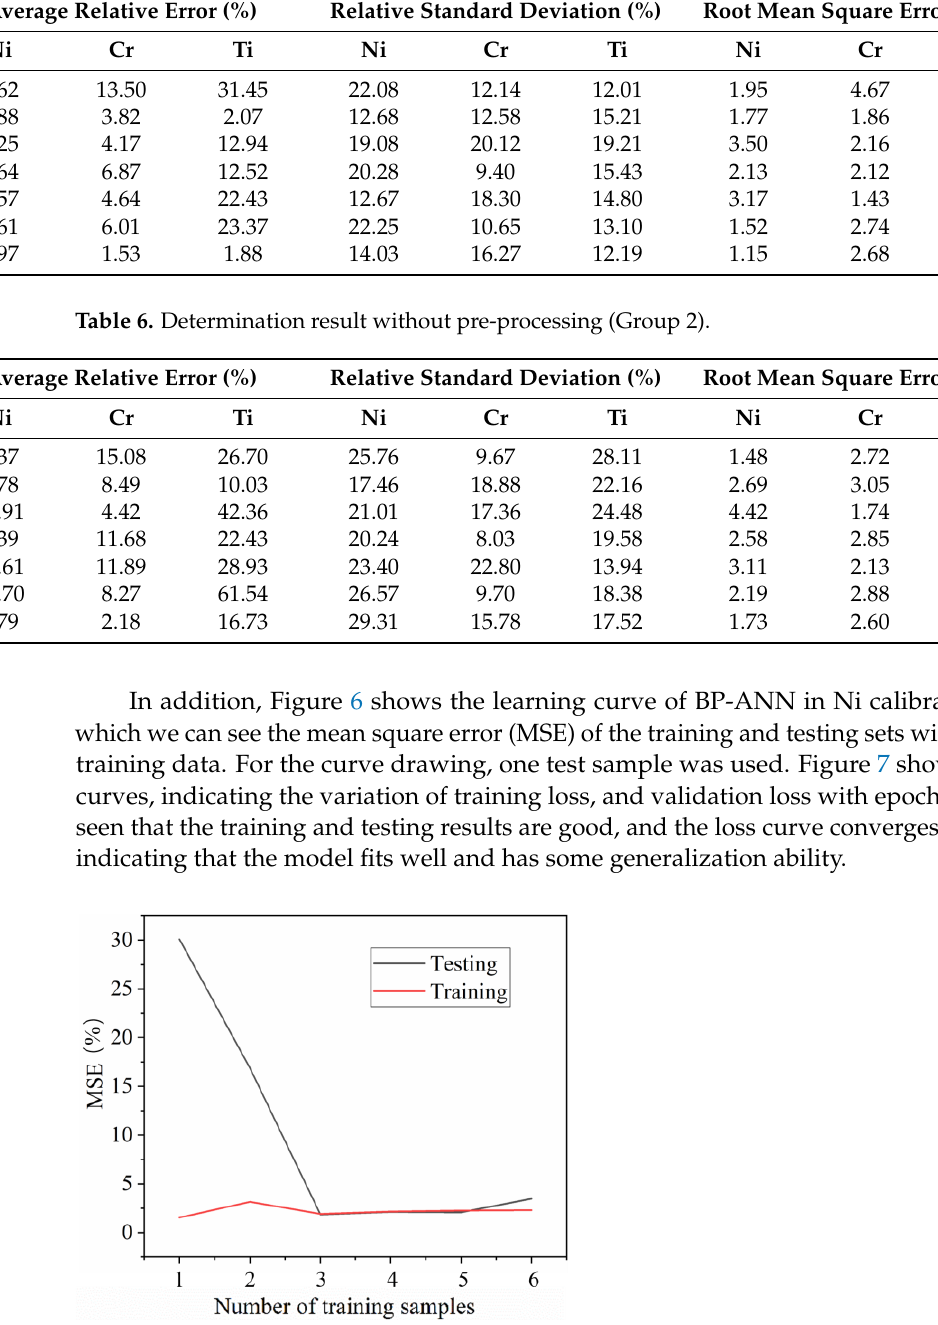
Table 5. Determination result of Ni, Cr, and Ti with BP-ANN (Group 1).